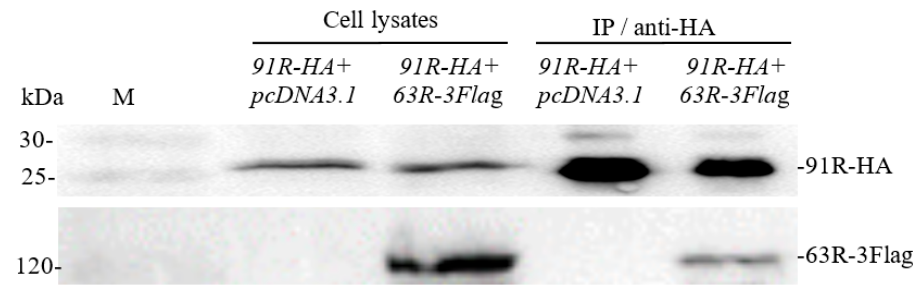
Figure 2. Western blot analysis for sample of testing interaction between RGV-63R and RGV-91R by co-IP. Cell lysates from HEK293T cells cotransfected with indicated plasmids ( 91R-HA + pcDNA3.1 , 91R-HA + 63R - 3Fla g) and IP (immunoprecipitated) protein complexes with indicated plasmids ( 91R-HA + pcDNA3.1 , 91R-HA + 63R - 3Fla g) are subjected to Western blot analysis using anti-HA and anti-Flag. Cells lysates and IP showed the bands of 91R-HA and 63R-3Flag. M: protein molecular mass marker.